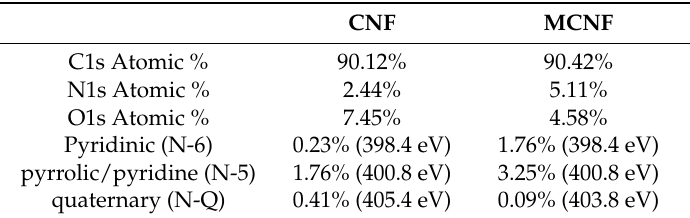
Table 1. The elemental analysis of CNF and MCNF.